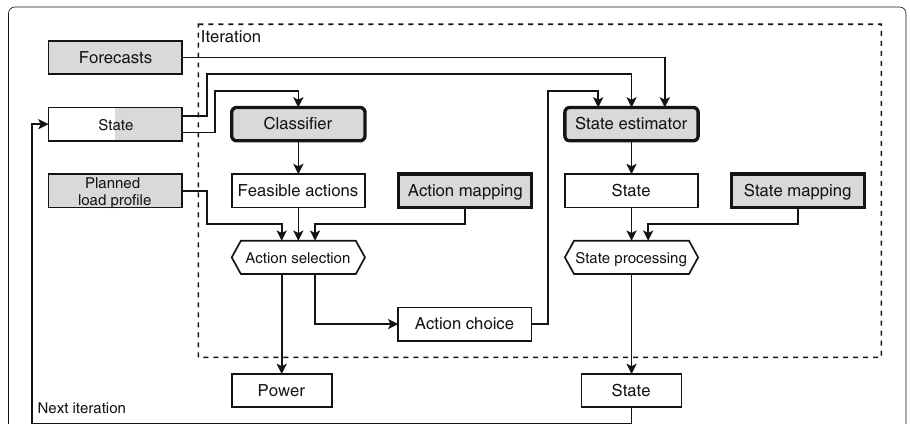
Fig. 2 The algorithm employed by the DSMgr iteratively determines a load profile using the model, parameters and variables provided by the EMS of the building. All data supplied by the EMS of the building is illustrated with a gray background and static information is additionally depicted with a bold